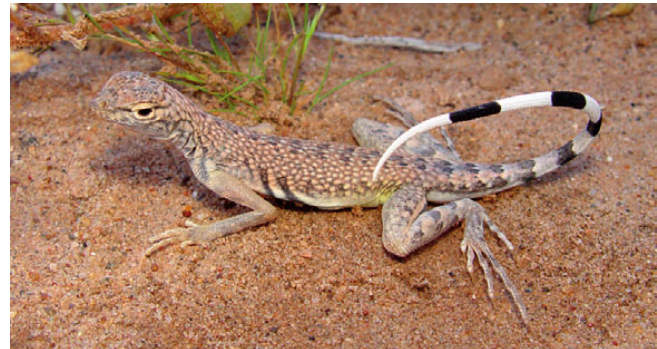
Figure 1. A desert lizard (Photo credit: Thomas C. Brennan) [21].